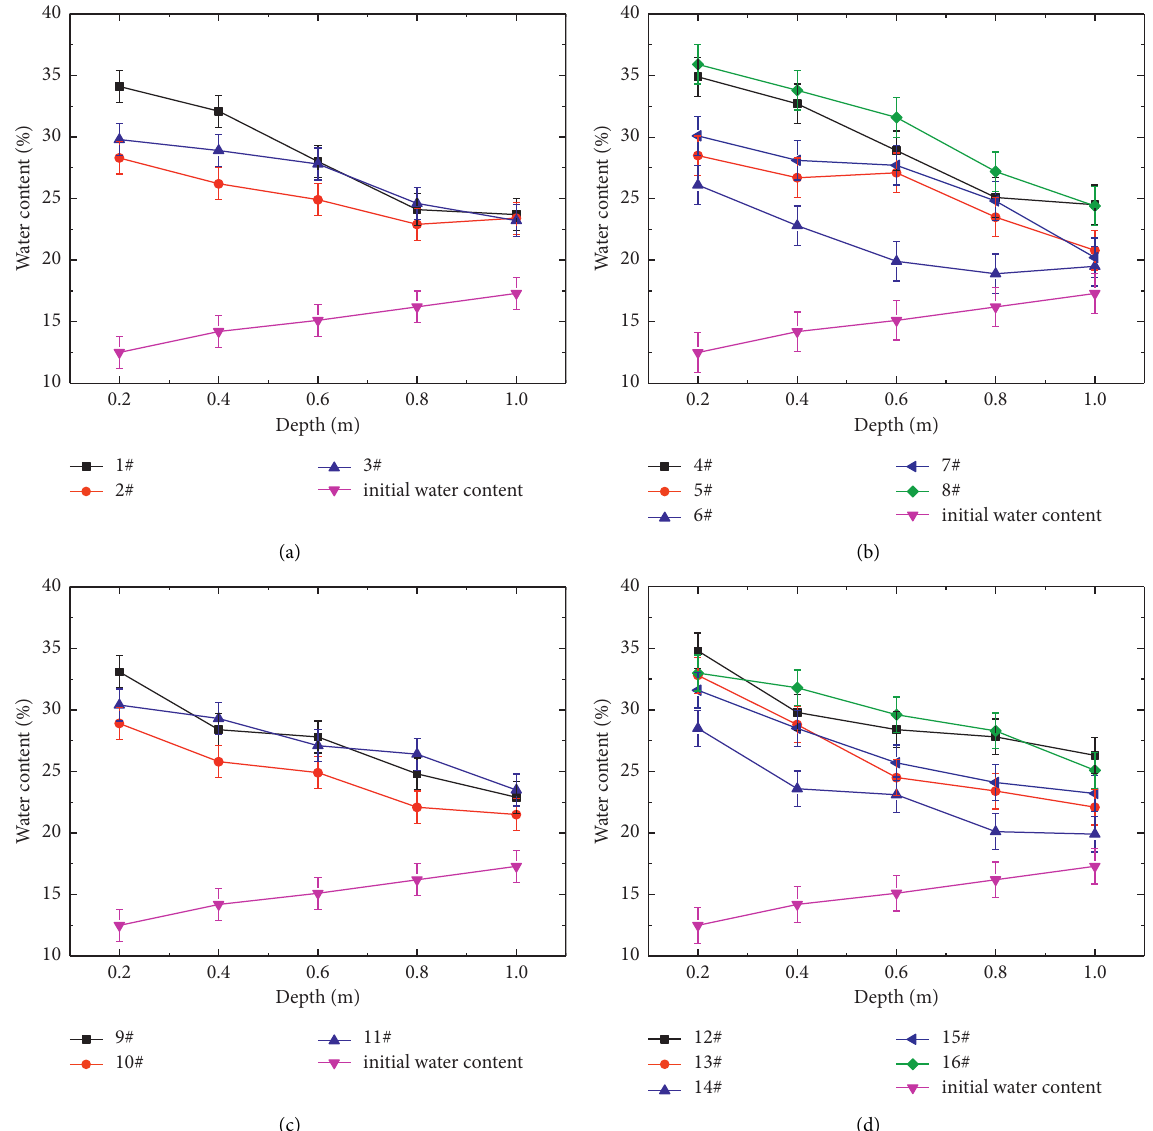
Figure 10: Water content at observation points (a) 1–3, (b) 4–8, (c) 9–11, and (d) 12–16 in the artificially simulated rainfall experiment (the error bar means the root mean square error of the water